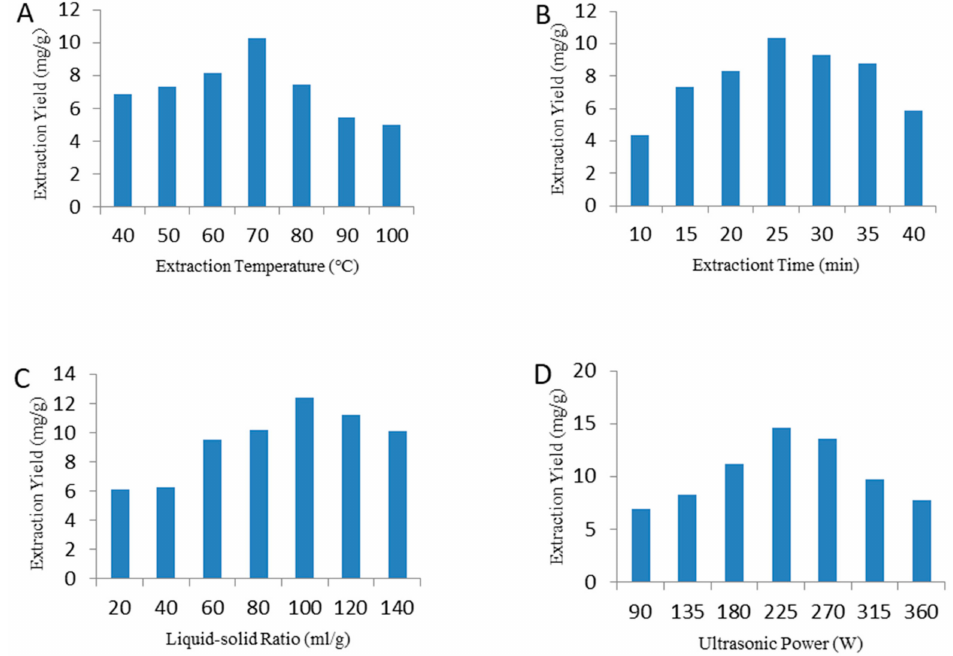
Figure 1. E ff ects of a di ff erent extraction temperature ( A ), extraction time ( B ), liquid-solid ratio ( C ), and ultrasonic power ( D ) on the extraction